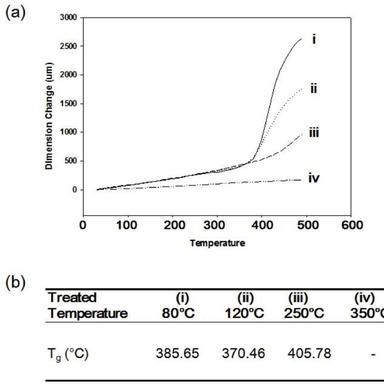
(a) TMA and thermal properties of PI films at different temperatures (°C), (a) 80 °C, (b) 120 °C, (c) 250 °C, (d) 350 °C, and (b) Glass transition temperature of PI films at different temperatures (°C). Here, the final curing time was 10 min.